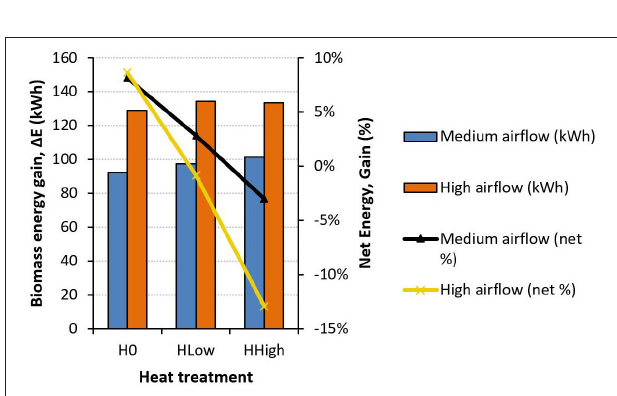
FIGURE 6 | Energy gains ( 1 E) (kWh) from natural air drying of bark material with and without supplemental heat along with net energy gain (%) when factoring in equipment energy